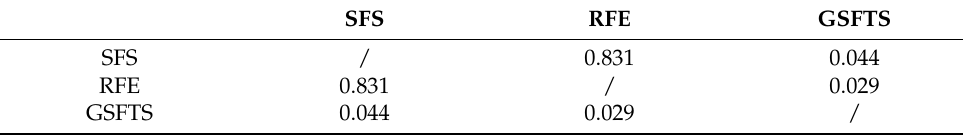
Table 11. P-value matrix for different feature selection methods.